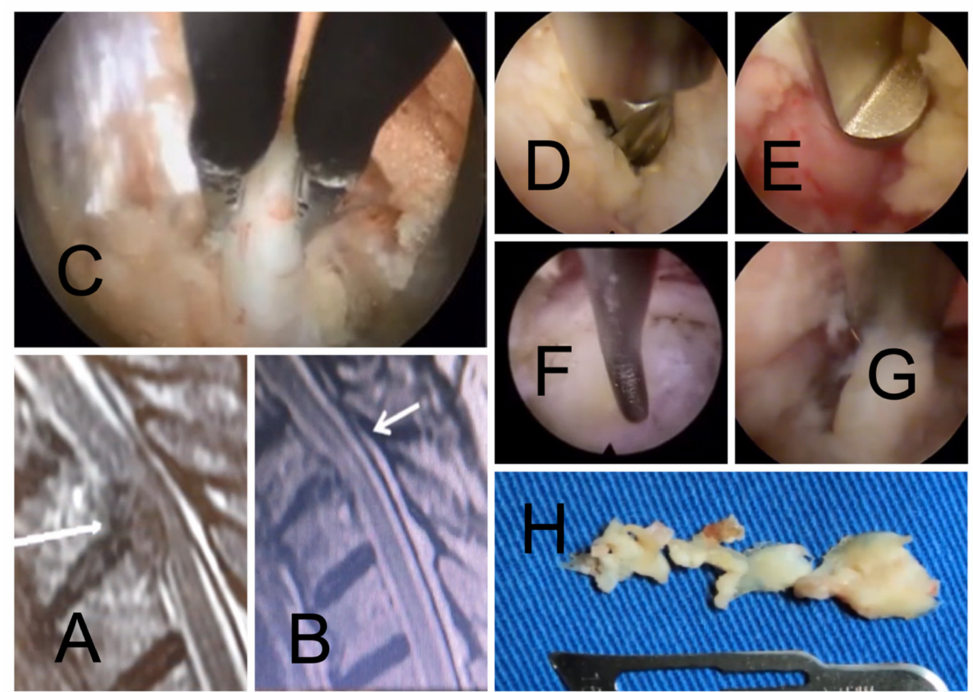
Figure 3. The preoperative ( A ) and postoperative ( B ) sagittal T2-weighted MRI scans of a patient who underwent transforaminal endoscopic T10/11 discectomy are shown. The white arrows point to the compressive pathology. The first author encountered the magna radicular artery ( C ) preventing direct access to the surgical neuroforamen. Instead of cauterizing and transecting it, the surgeon performed a wide foraminoplasty to improve access to the herniated disc with an endoscopic drill ( D ) and Kerrison rongeur ( E ). These tactical maneuvers allowed mobilization, retraction, and preserving this important contributor to the Adamkiewicz vascular supply system of the thoracolumbar spinal cord and cauda equina. The discectomy was completed by delivering the herniation from below the posterior longitudinal ligament with an endoscopic nerve hook ( F ) and removing it with an endoscopic grasper ( G ) piecemeal ( H